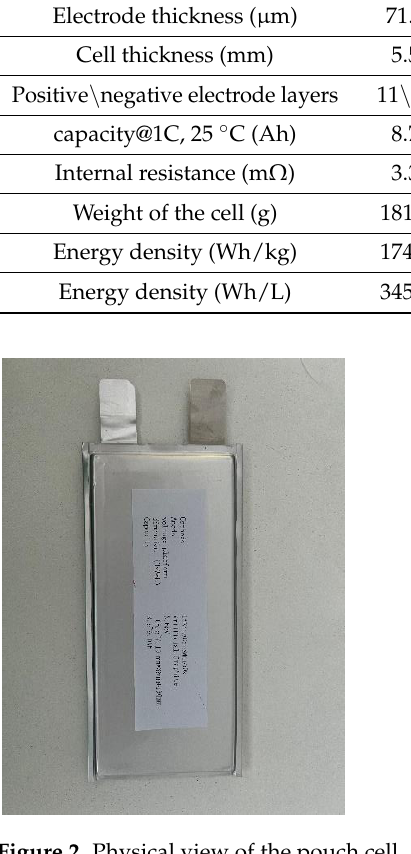
Table 3. Size and basic performance information of pouch cell.